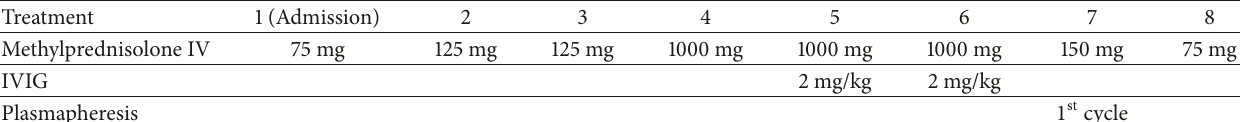
Table 1: Treatment during hospital stay by